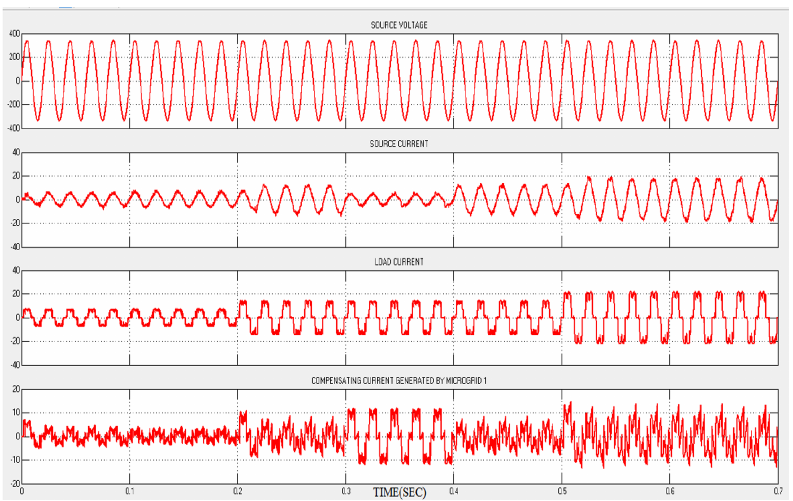
Figure 14. Voltage and current waveforms of phase ‘a’ when Microgrid 1 integrates into the